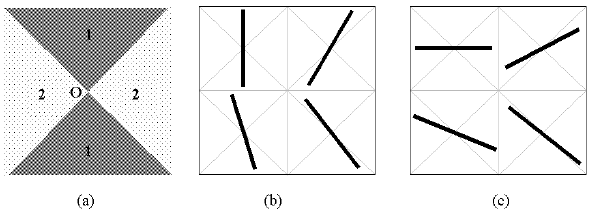
Figure 2. Samples of nearly vertical and nearly horizontal lines